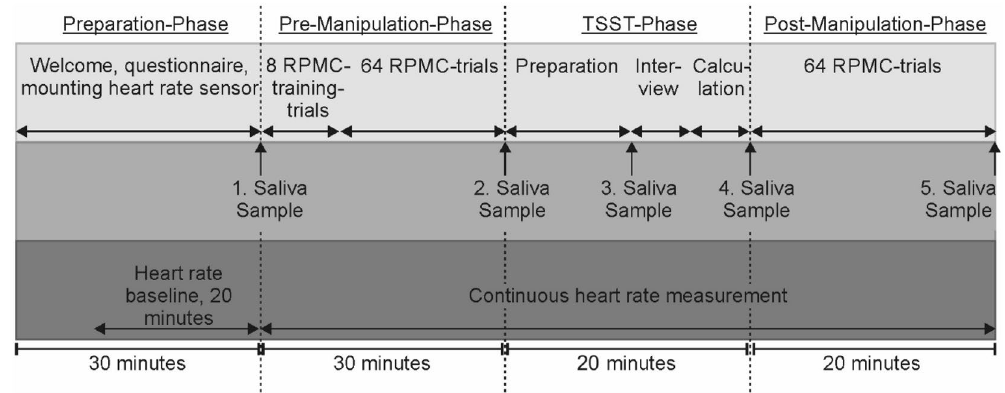
Figure 2. Procedure of the experimental session divided by phases (columns) and features (rows). Top row (pale grey) shows the participant’s tasks throughout the experiment. Middle row (medium grey) displays time points of collection of saliva-samples (cortisol measurement) and the lower row (dark grey) reflects the aggregation of heart rate